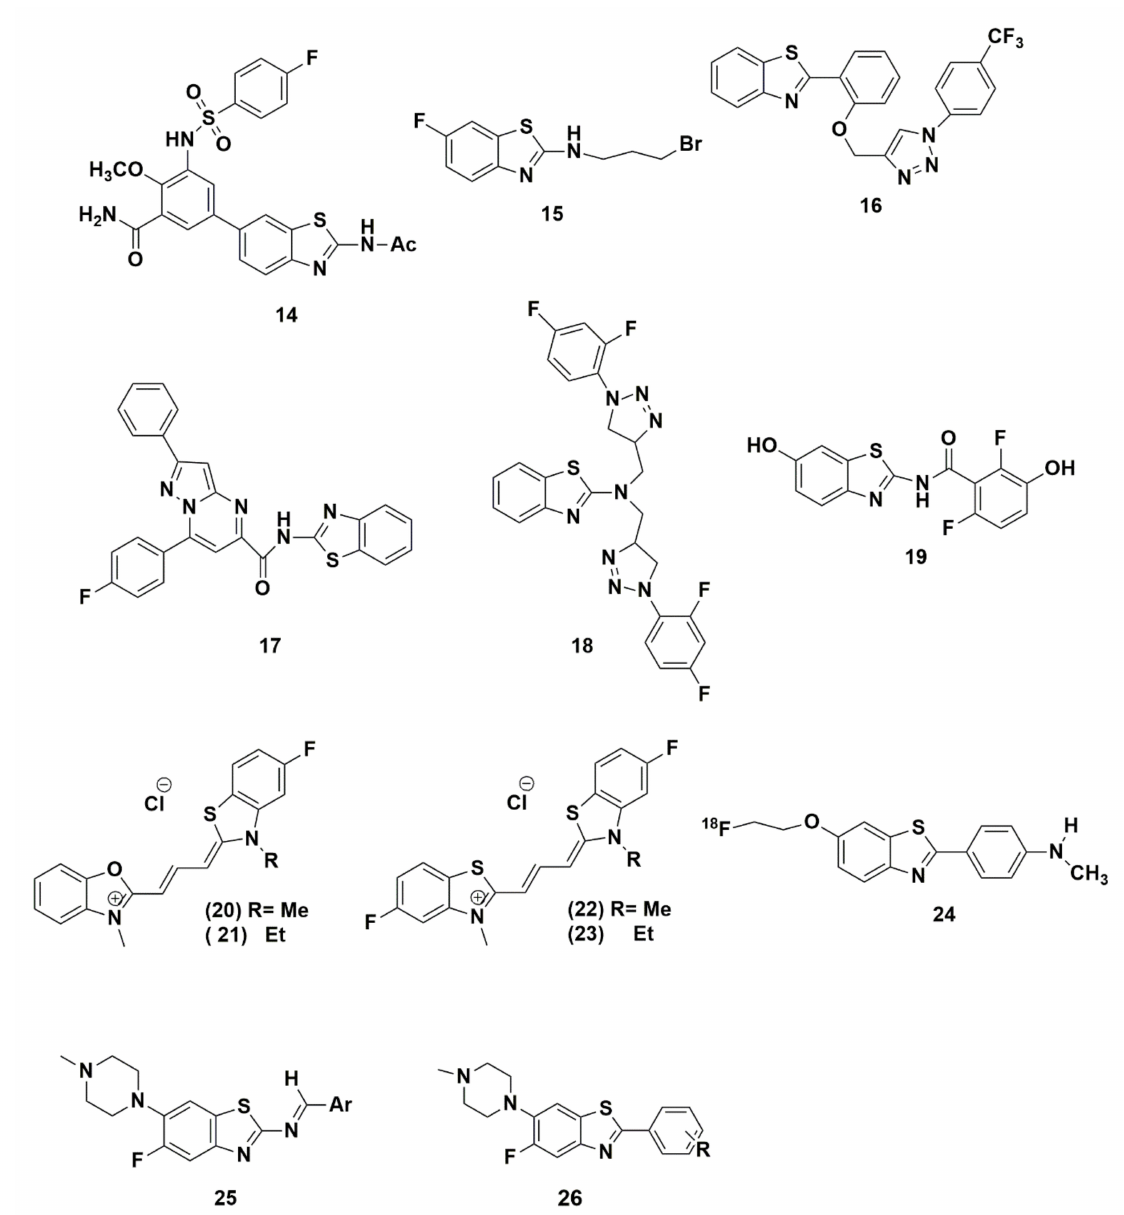
Figure 7. Benzothiazole derivatives incorporating